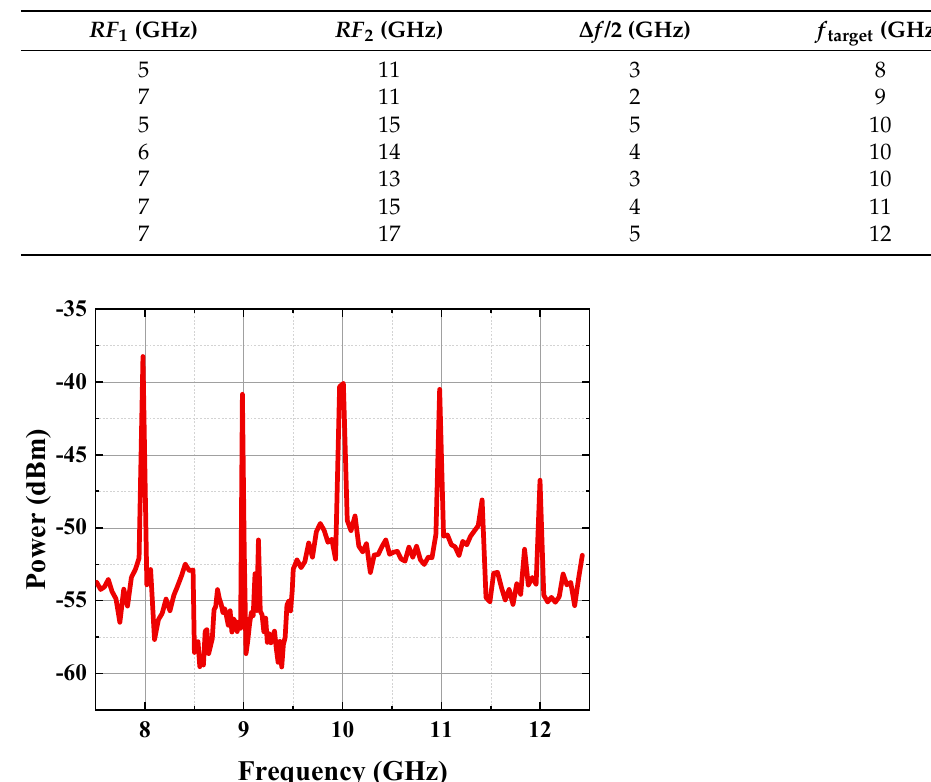
Table 1. The RF signal data in experiment.